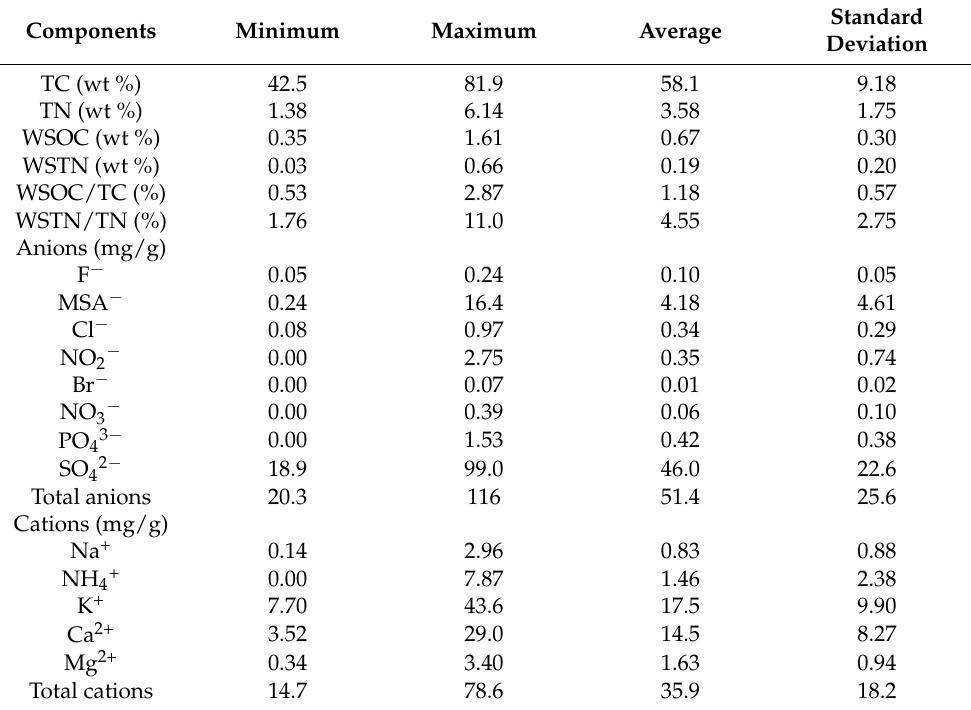
Table 1. Summary of carbon, nitrogen, and ion analyses of the chimney deposits from domestic wood stove (n =